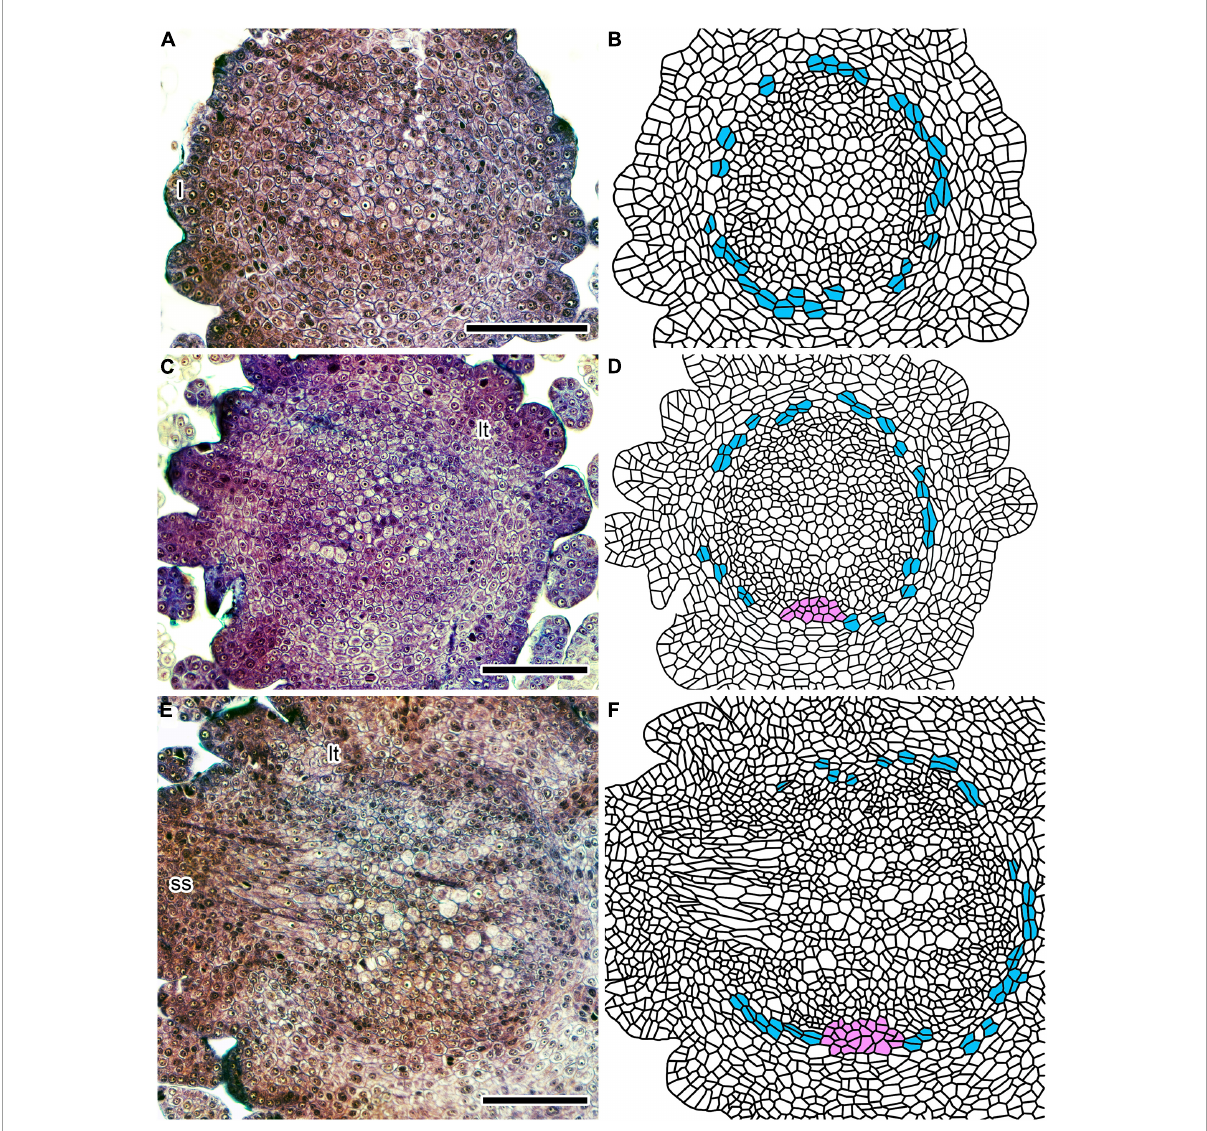
FIGURE2 Tissue differentiation processes in an immature Lycopodium clavatum shoot (sample #P1) within 1 mm from the shoot apex. (A,C,E) Cross-sections at 175, 235, and 360 µ m from the shoot apex, respectively. (B,D,F) Line drawings of sections on the left. Cells encircling vascular tissue (blue) divide periclinally to supply cortical cells. A mass of parenchymatous cells (ventral tissue) is colored in pink. Scale bars, 100 µ m. ss, small shoot; l, leaf primordium; lt, leaf